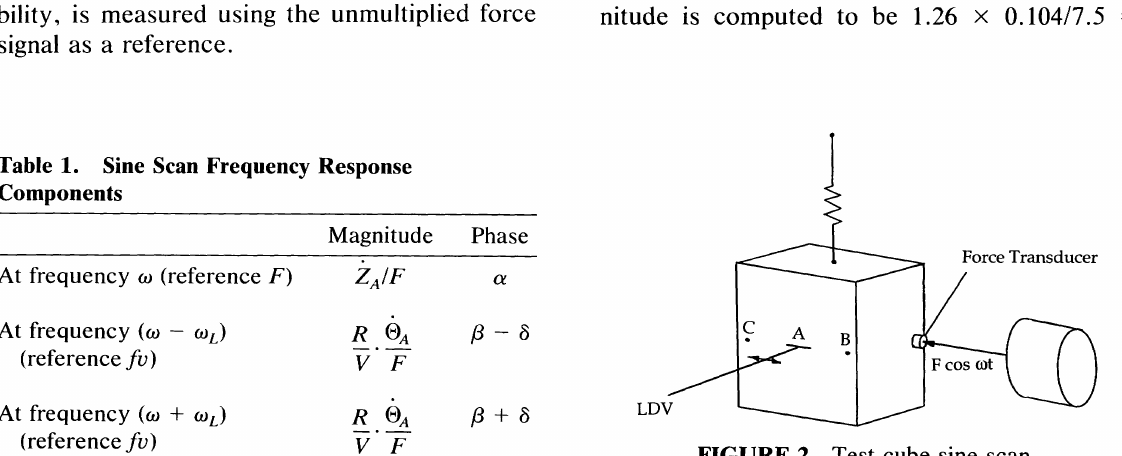
FIGURE 2 Test cube sine